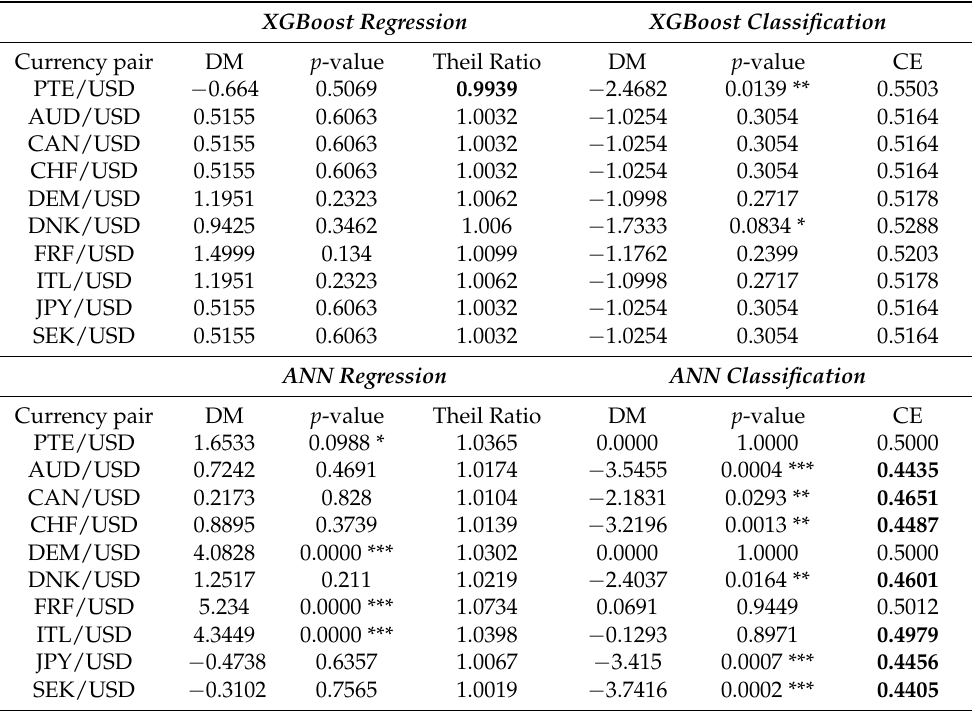
Table 5. One-month-ahead forecasting of exchange rate differentials/direction without fundamentals using ANN/XGBoost.